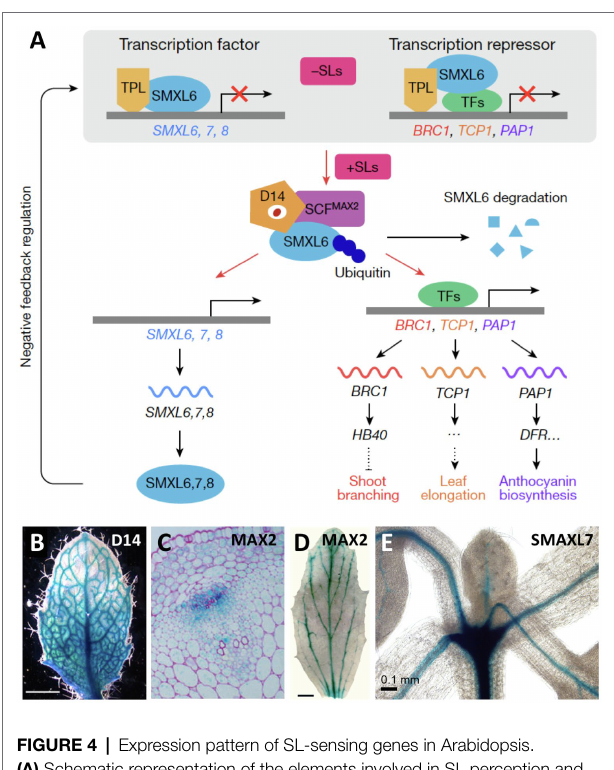
FIGURE 4 | Expression pattern of SL-sensing genes in Arabidopsis. (A) Schematic representation of the elements involved in SL perception and signal transduction, including the SL receptor D14, the ubiquitin conjugating enzyme complex SCF MAX2 containing the F-box protein MAX2, and the redundantly acting transcriptional repressors SMAXL6, SMAXL7, and SMAXL8, which regulate the expression of target genes such as BRC1 . (B–E) Expression pattern of the SL perception and signaling genes D14 (B) , MAX2 (C,D) , and D53/SMAXL7 (E) , as indicated, revealed by promoter::GUS analysis. Note highest expression in vascular strands as revealed in whole- mount preparations (B,D,E) , and in a transverse section of the stem [ C ; modified with permission from Wang et al., 2020 (A) ; Chevalier et al., 2014 (B) ; Stirnberg et al., 2007 (C) ; Shen et al., 2007 (D) ; and Soundappan et al., 2015 (E) ].